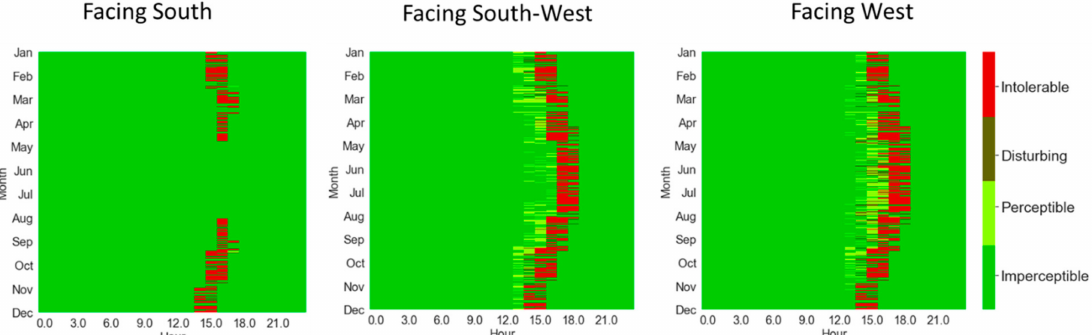
Figure 7. Glare in west orientation at Chicago:AC1 strategy with the occupant in three di ff erent view positions relative to window.